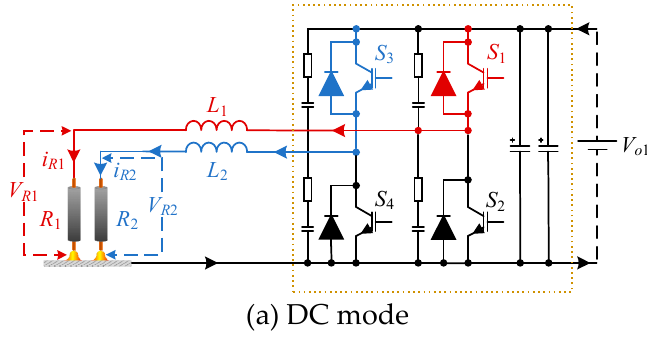
Figure 6. Multi-output welding power-supply system.